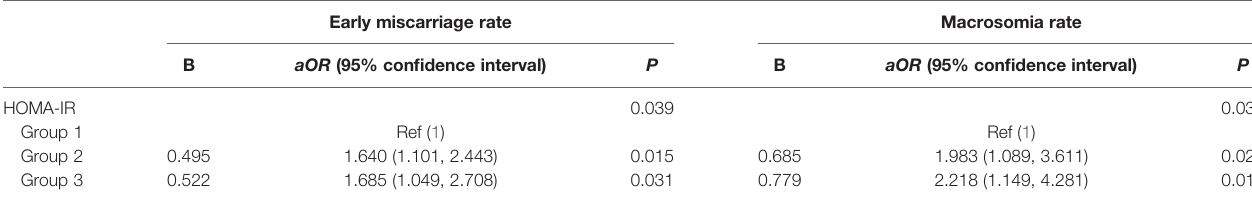
TABLE 4 | Logistic regression analysis to account for confounding variables of early miscarriage and